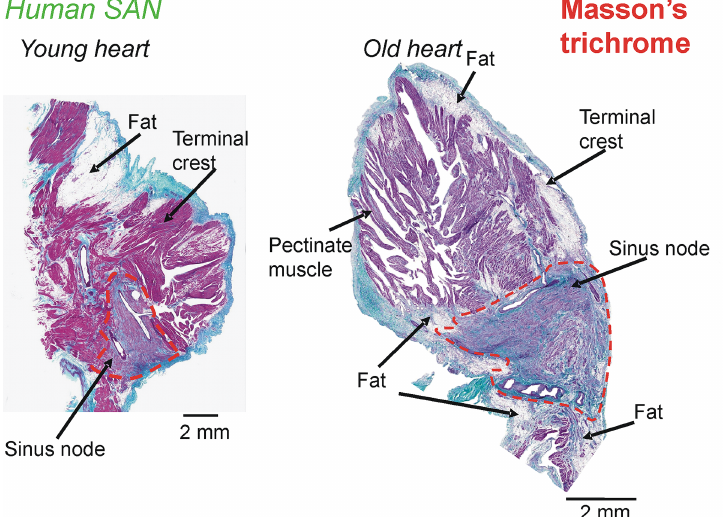
Fig 9. Fibrosis within the old human SAN. The dashedred lines delineateSAN pacemakers.The left panel shows a representativeslice from a young heart whilethe right panel shows a slice from an old heart. The Masson’s trichrome staining shows cell cytoplasm (pink) and connectivetissue or fibrosis (blue, blue-green). Whereas the left panel’sSAN regionis dominated by pink staining, the right panel has diffuse fibrosis.